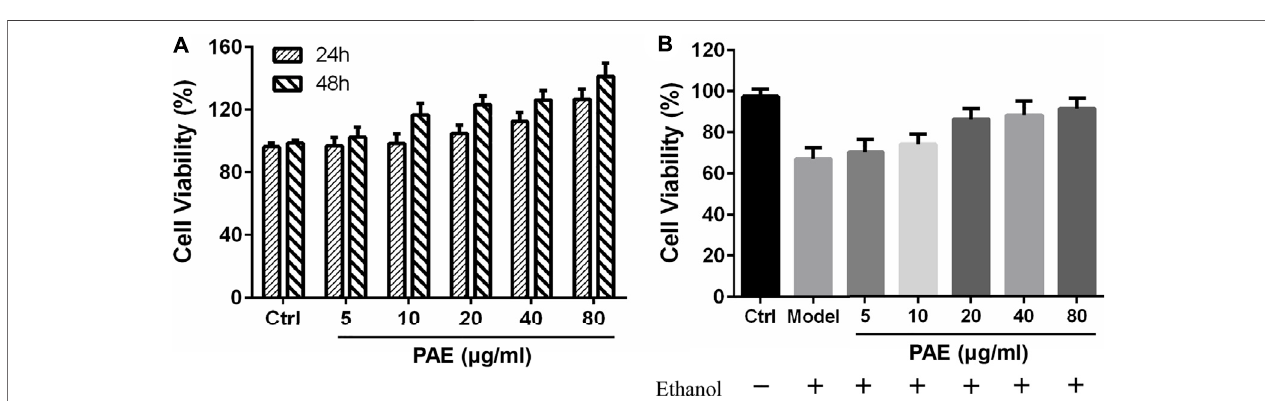
FIGURE 3 | Effects of PAE on the proliferation of GES-1 cells. (A) The pretreatment of PAE promoted cell viability with 24 and 48 h treatment (B) Cell viability in the presence or absence of 100 μ M ethanol for 24 h treatment.